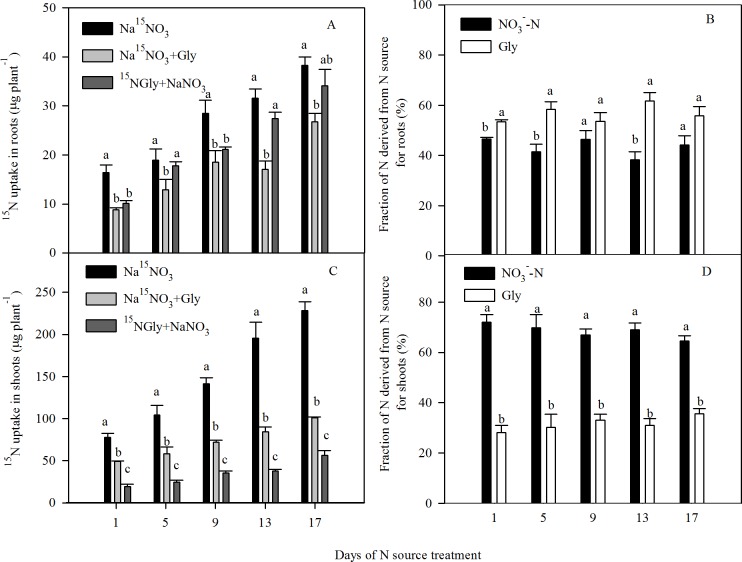
Time course of changes in 15N uptake by pak choi seedlings exposed to Na15NO3, Na15NO3 + Gly or 15NGly + NaNO3.(A) Uptake of 15N-labelled NO3--N and Gly in the roots, (B) fraction of N derived from each N source for the roots, (C) uptake of 15N-lablled NO3--N and Gly in the shoots, and (D) fraction of N derived from each N source for the shoots. Data are mean ± SE (n = 3). Different letters indicate significant differences between treatments at P < 0.05, LSD test.